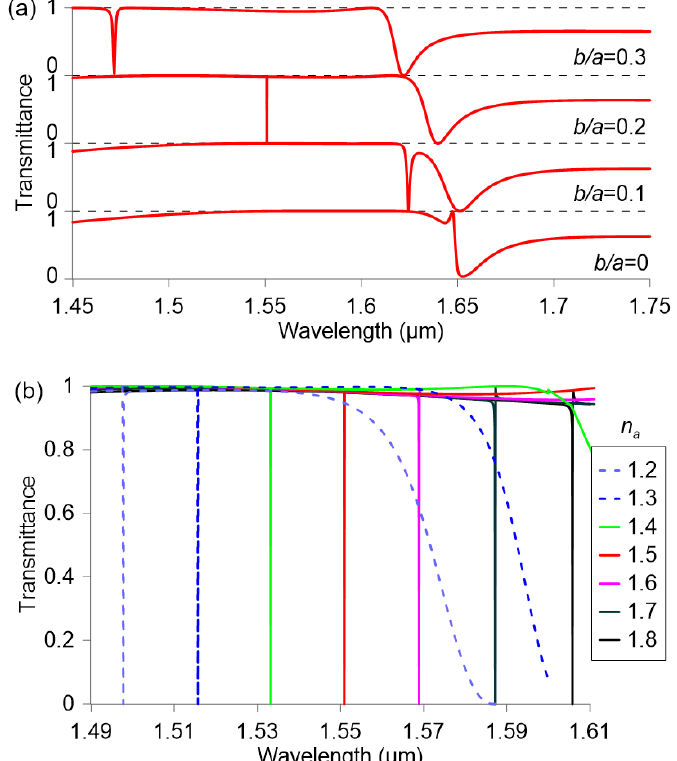
Figure 6. Transmittance of a metasurface composed by silicon nanocuboids ( h = 480 nm, h / a = 0.88, g = 50 nm) patterned on a glass substrate for ( a ) different relative hole size ( n a = 1.5) and ( b ) different analyte refractive index ( b / a =